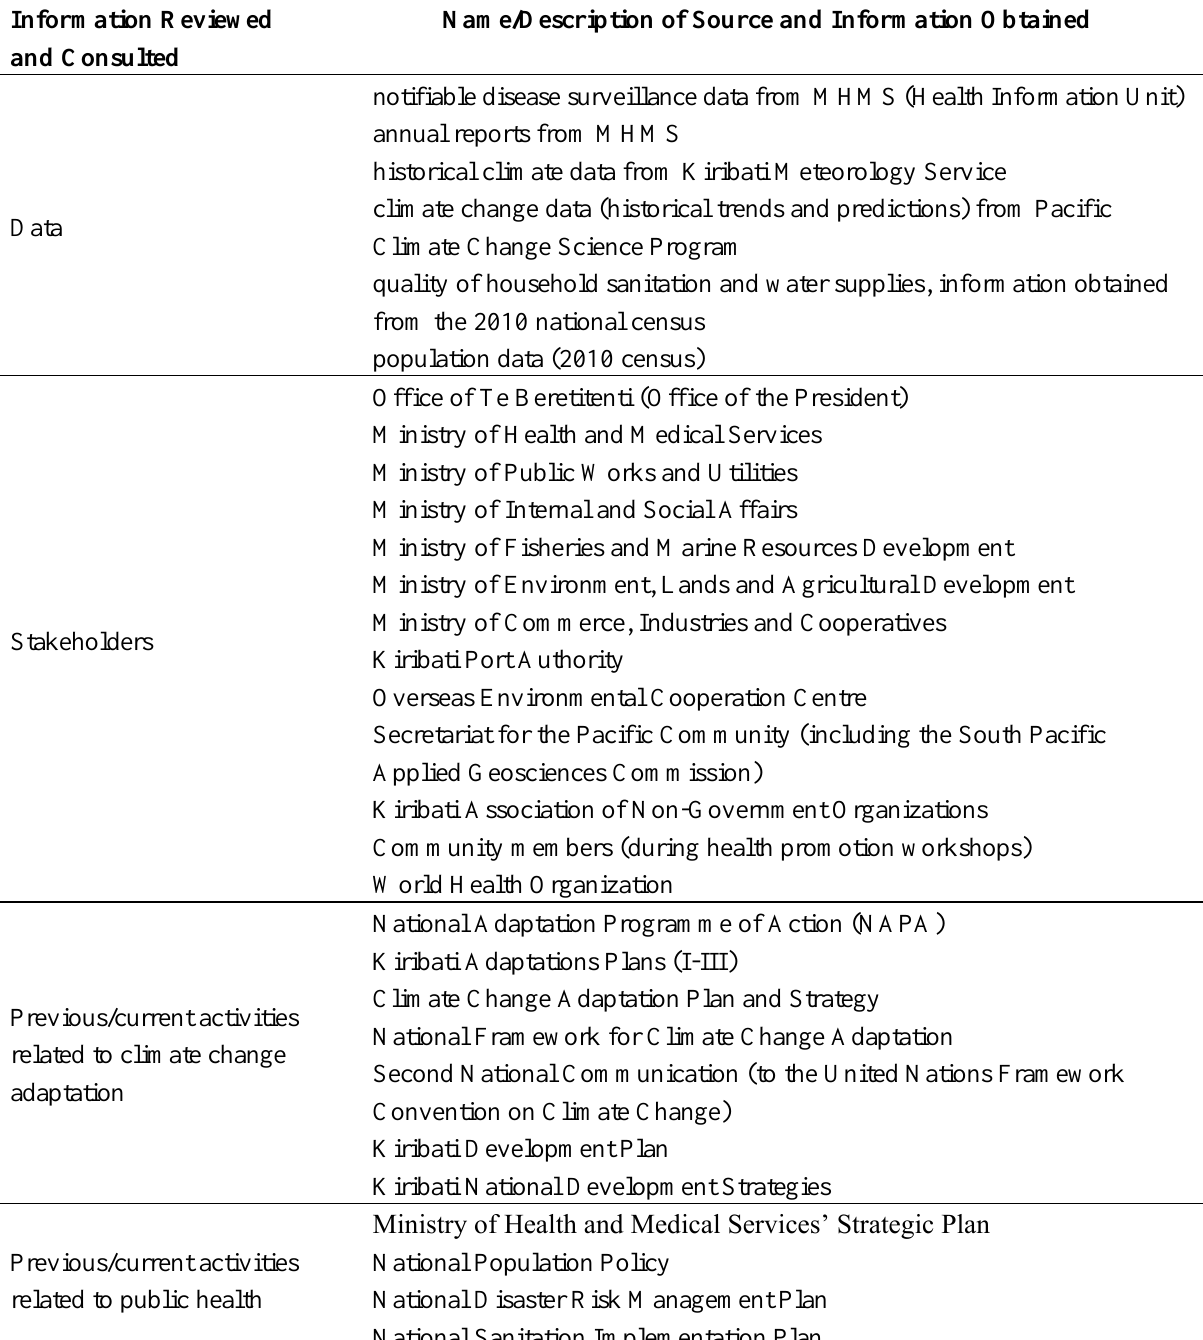
Table 2. Information considered in the Kiribati climate change and health vulnerability